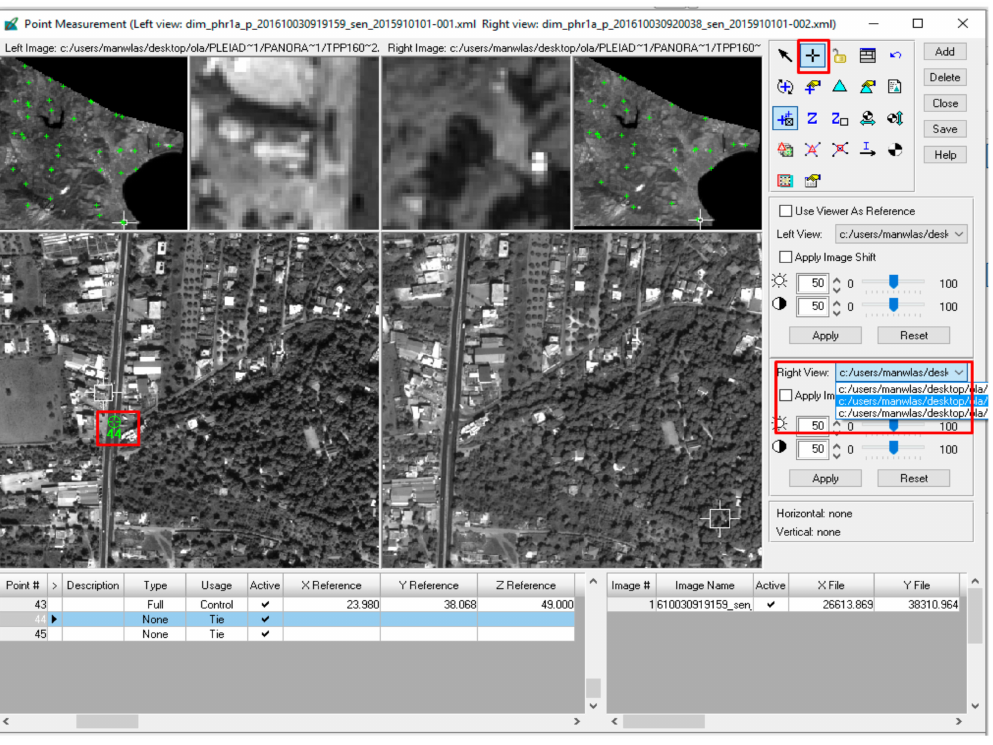
Figure 3. View of the ERDAS IMAGINE Photogrammetry for the GCP collection and preparation. Table 2. The characteristics of the analyzed Pleiades tri-stereo